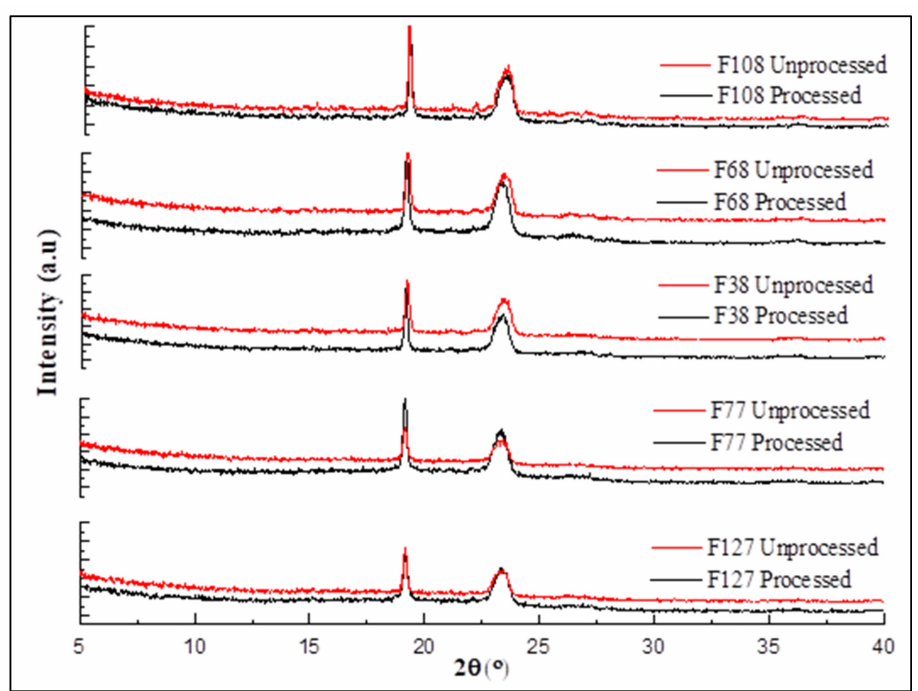
Figure 7. XRD diffractograms of Pluronics before and after processing. Pluronics are semi-crystalline polymers due to the presence of crystalline PEO and amorphous PPO fractions in the structure. The diffractograms of all Pluronics (processed and unprocessed) were identical with peaks at 19 and 23 ◦ 2 θ originating from the PEO fraction. Similar to DSC, this also confirms that the CO 2 processing